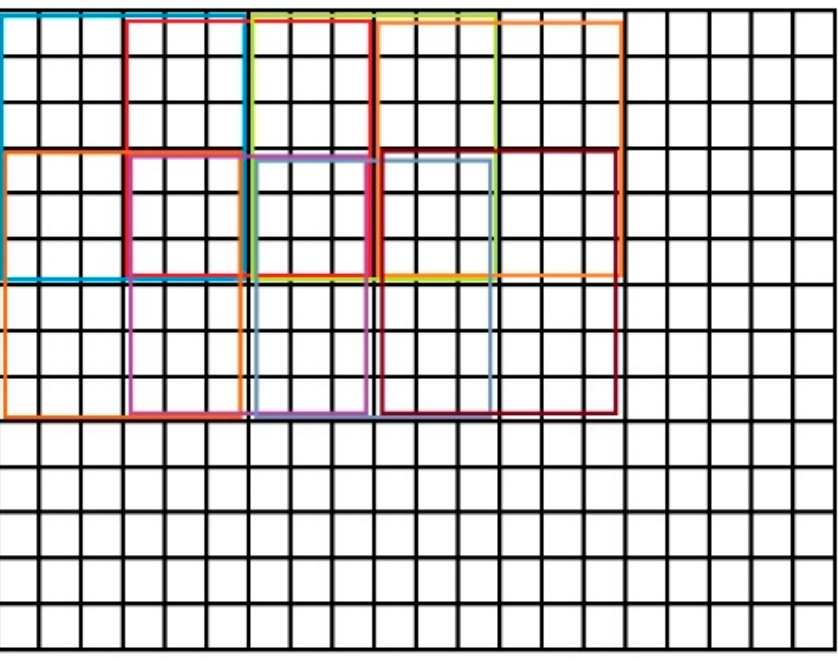
Figure 3. Representation of block division.